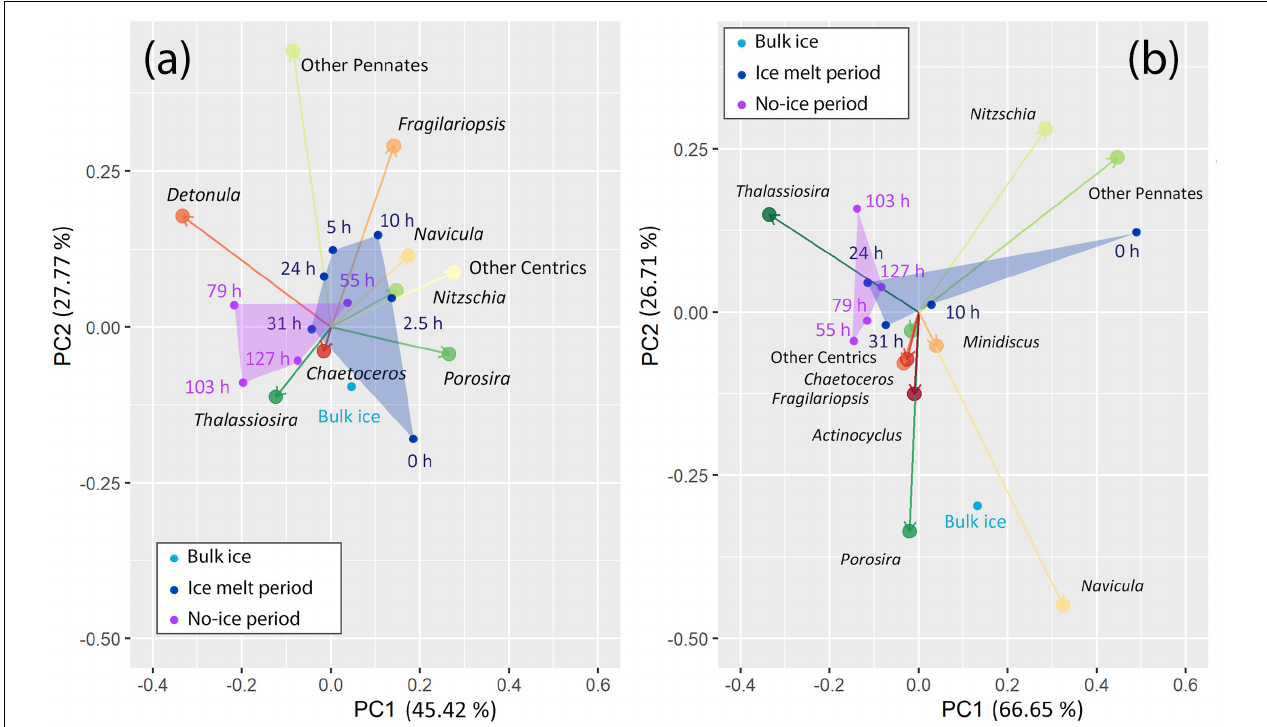
FIGURE 4 | Biplot of principal component analysis (PCA) on the community composition at different sampling times. (a) Light microscopy (LM); (b) 18S rDNA metabarcoding. Algal communities of different sampling times are in different colors: Light blue, bulk ice; navy, ice-melt period; purple, no-ice period. Algal communities of latter two sampling periods are in polygons. Hellinger distance is used for the ordination. The proportions shown in percent indicate the contributions of the principal components to the total variance in the community